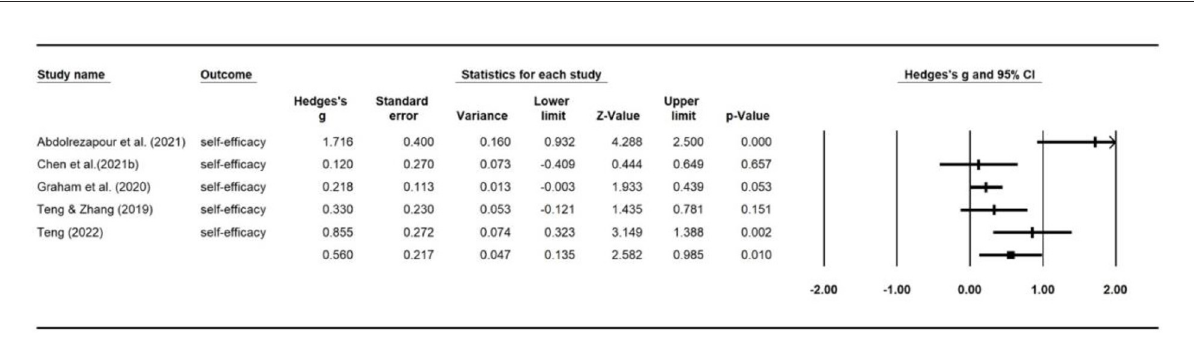
of sessions per week, whereas the intensity of each session only positively influenced students’